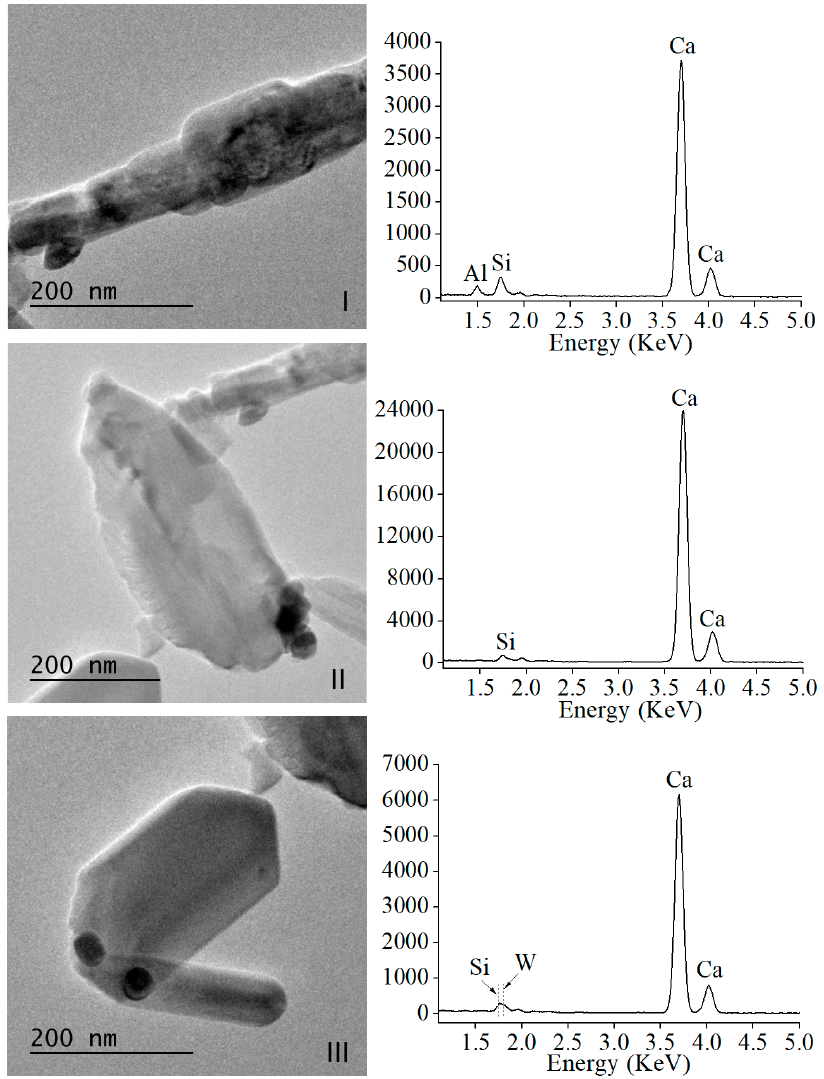
Figure 2. Individual TEM micrographs of un-hydrated MTA Repair HP material taken from (I), (II), and (III) sub-areas of Figure 1b, and corresponding energy dispersive X-ray (EDX) analysis (left column). The y-axis values of EDX plots correspond to acquired energy counts.